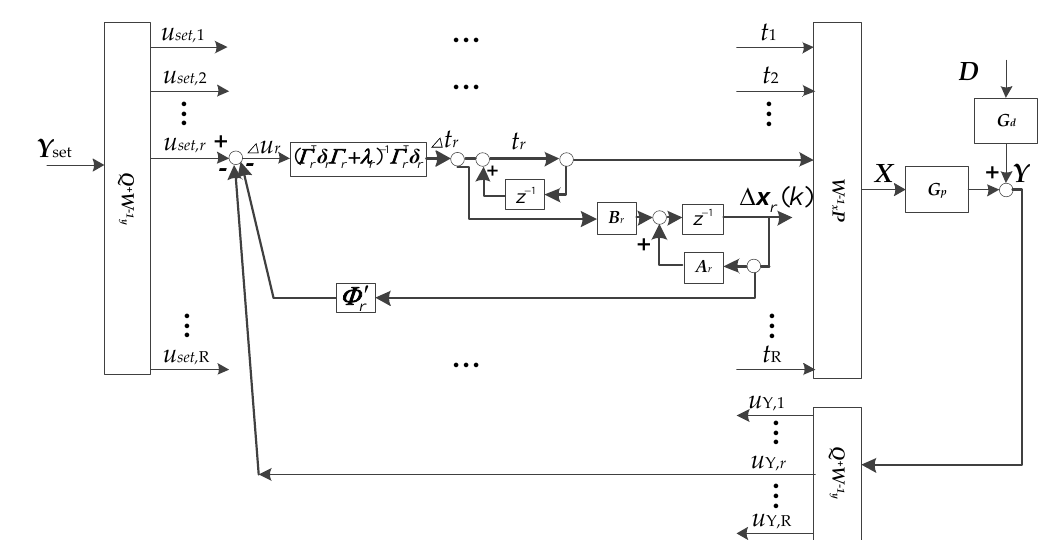
Figure 3. The control structure of the move form state mode.